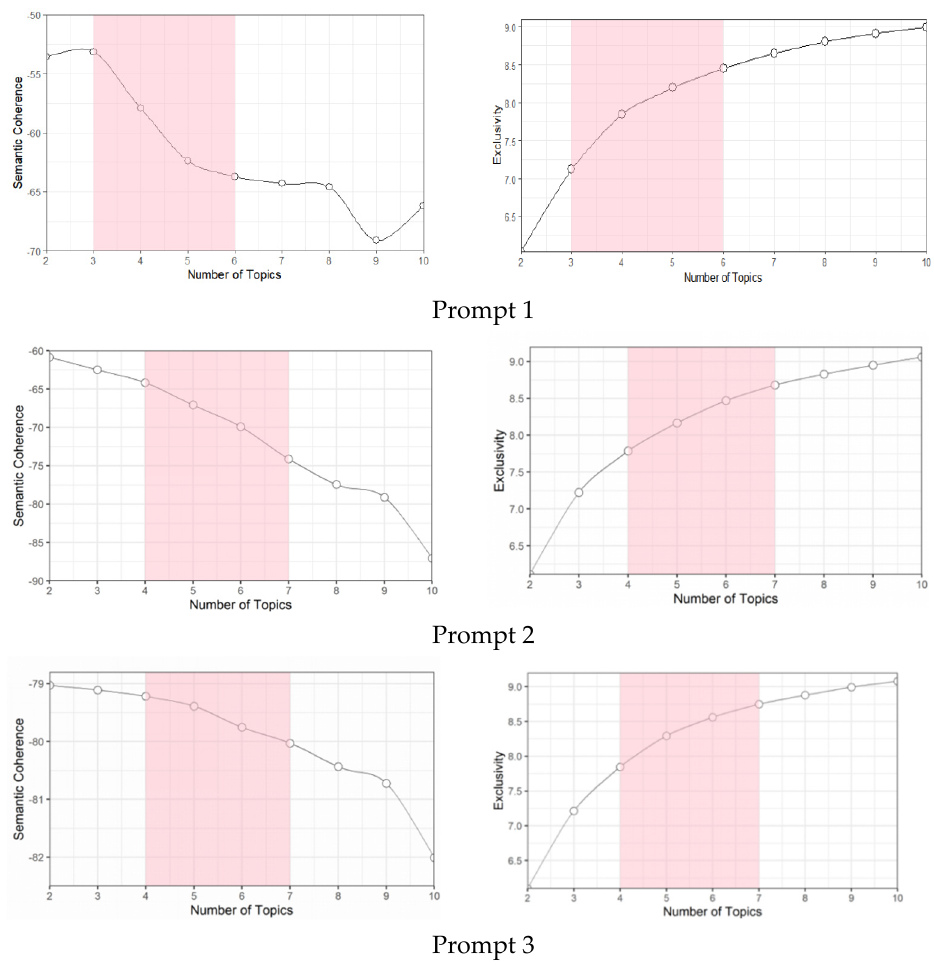
Figure 1. Optimal topic selection. A set of the number of topics is displayed according to two semantic coherence and exclusive diagnostic statistics. The shaded rectangle displays the range in which topics were evaluated for substantive meaning.